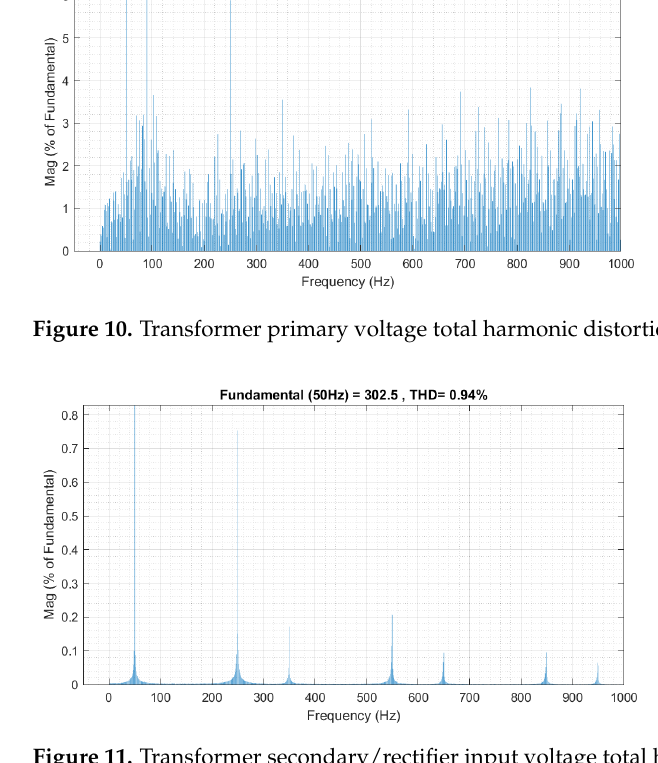
Figure 11. Transformer secondary/rectifier input voltage total harmonic distortion .